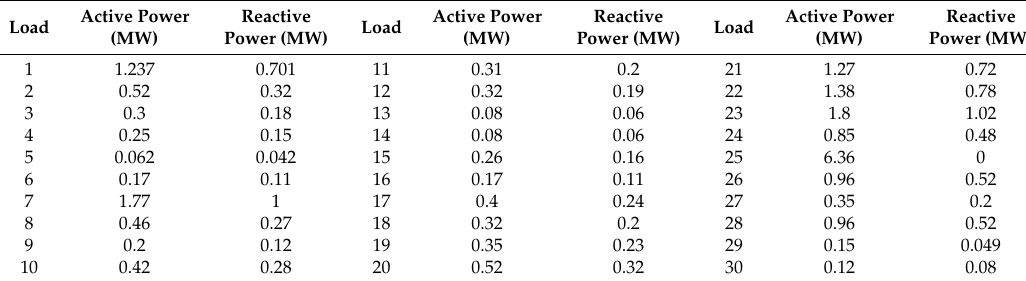
Table 1. The active and reactive power demand.